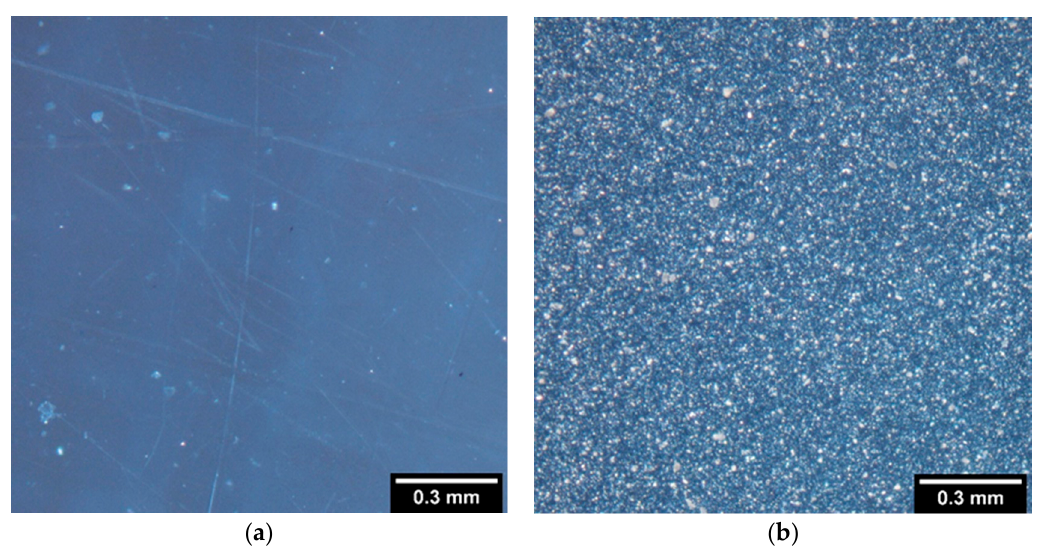
Figure 3. PLA films without OA ( a ) and with 0.3% of OA ( b ) as obtained by polarization microscopy.